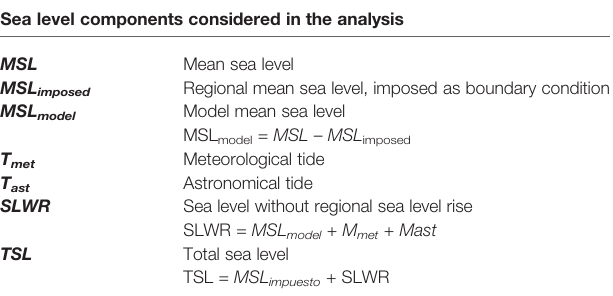
TABLE 2 | Sea level components considered in the analysis. Sea level components considered in the analysis MSL